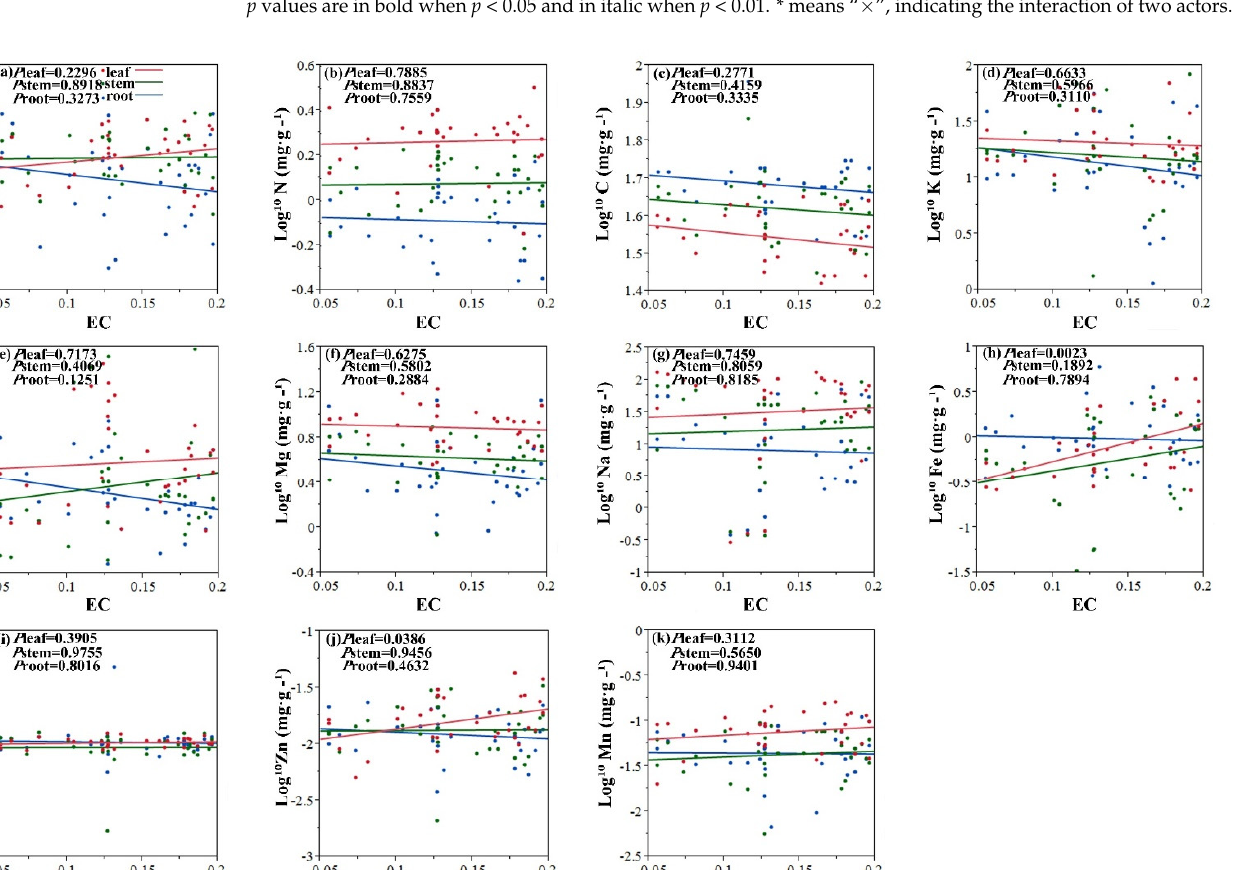
Table 2. Two-way ANOVA was performed to assess the effects of salt tolerance type, plant tissue parts and their con- nection to element concentrations.